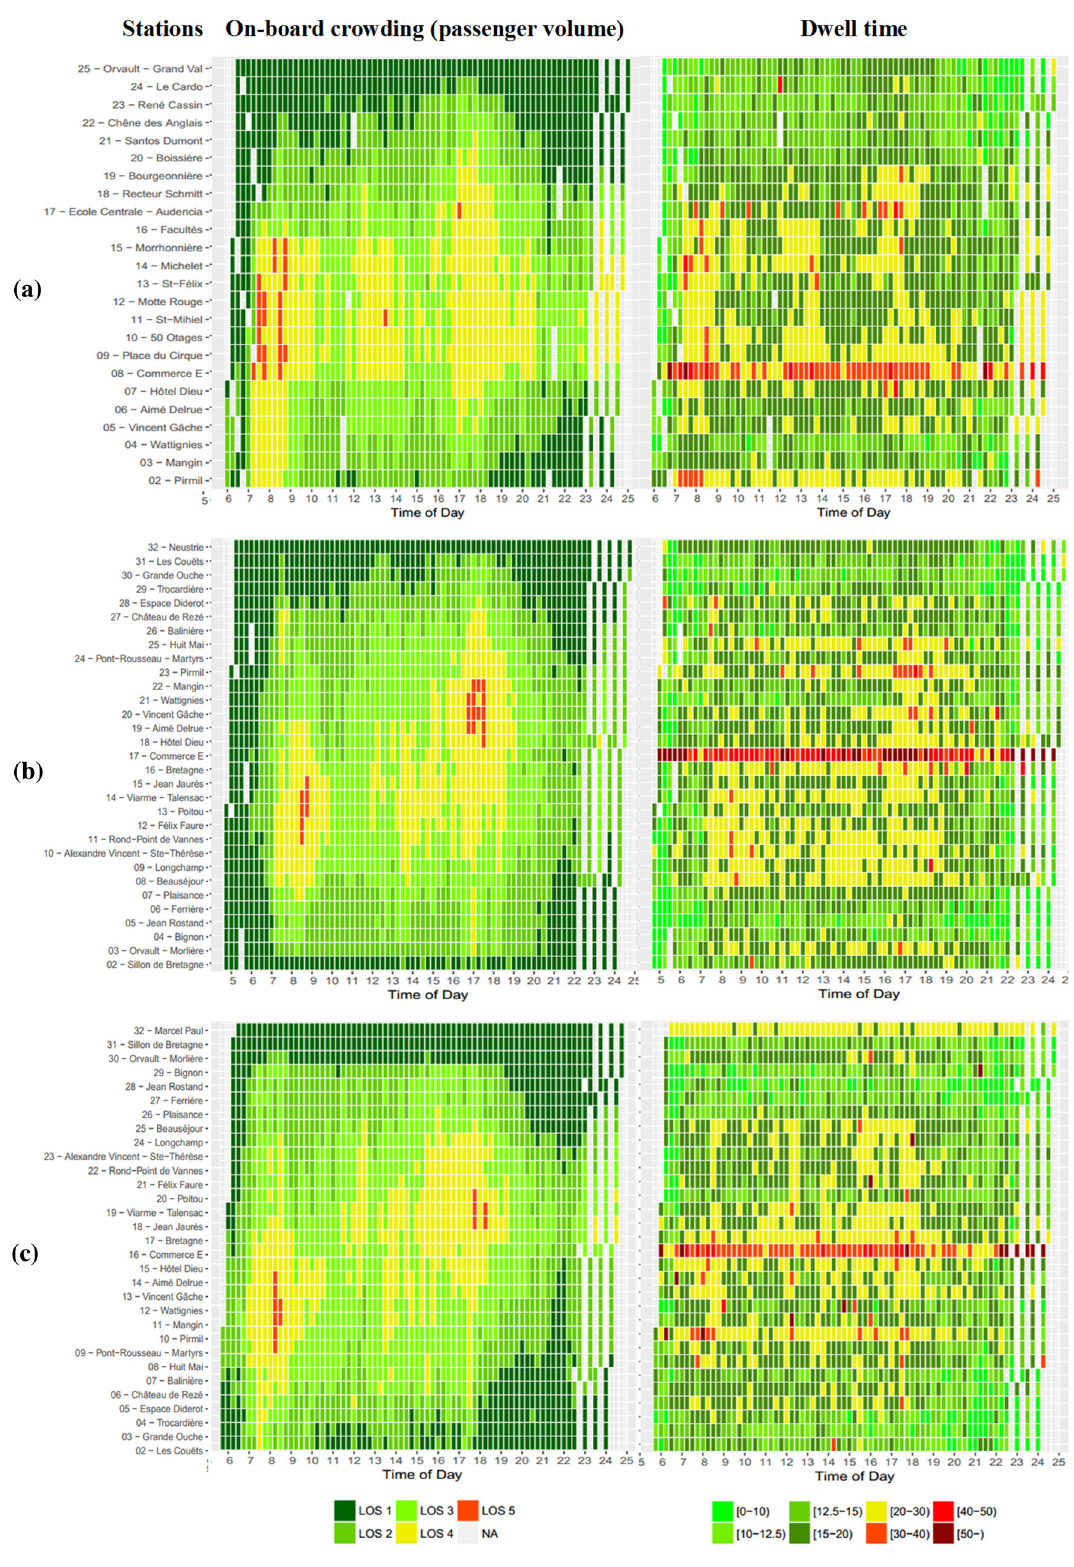
Fig. 3 Dwell time heat maps for each line and direction: a Line 2 northbound. b Line 3 southbound. c Line 3